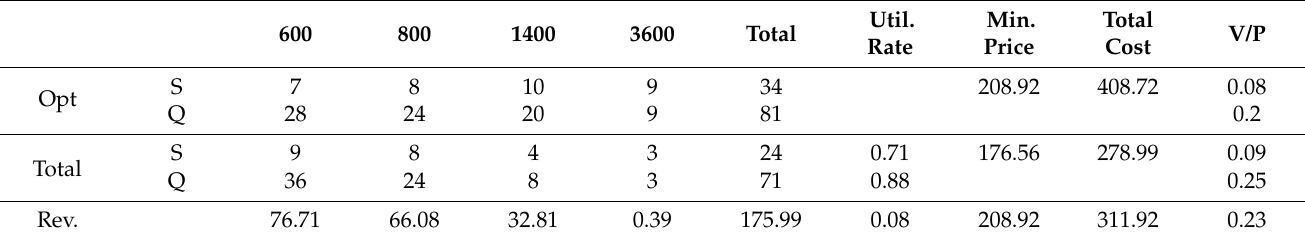
Table 14. Result of Genetic Algorithm and Random